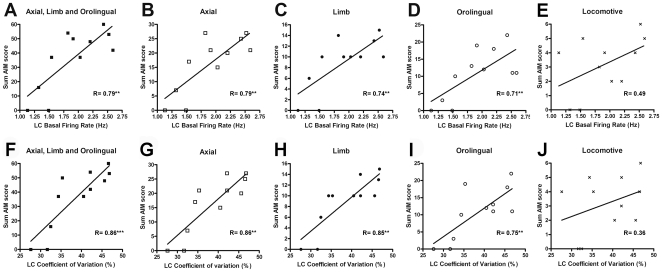
Regression analysis of the severity of dyskinesia and the electrophysiological parameters of locus coeruleus neurons in dyskinetic animals.The electrophysiological parameters of LC neurons are represented on the abscissa and the sum AIMs on the ordinate axis. The basal firing rate was correlated with the sum AIMs (A), and the axial (B), limb (C) and orolingual (D) subtypes. The coefficient of variation also correlated with the sum AIMs (F) and the axial (G), limb (H) and orolingual (I) subtypes. Locomotive behaviour was not correlated with the basal firing rate (E) or with the coefficient of variation in the LC (J). Each symbol represents an animal. Only 6-OHDA lesioned animals treated with L-DOPA (8 dyskinetic and 3 non-dyskinetic) are included in the analysis.